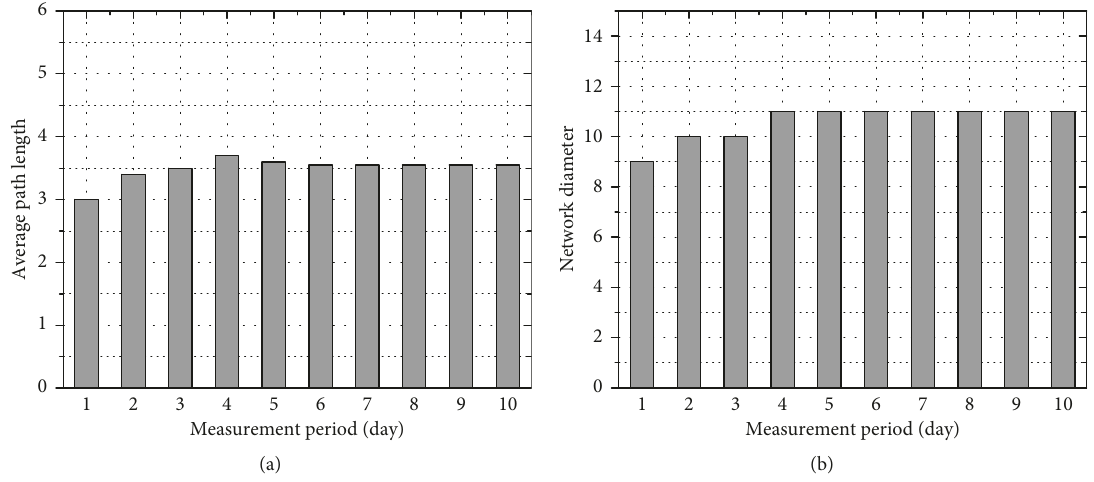
Figure 1: Path length. (a) Average path length. (b) Network diameter.